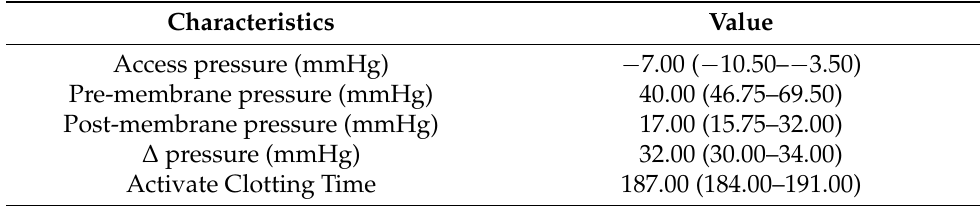
Table 2. Operational characteristics of CO 2 RESET in the three treated